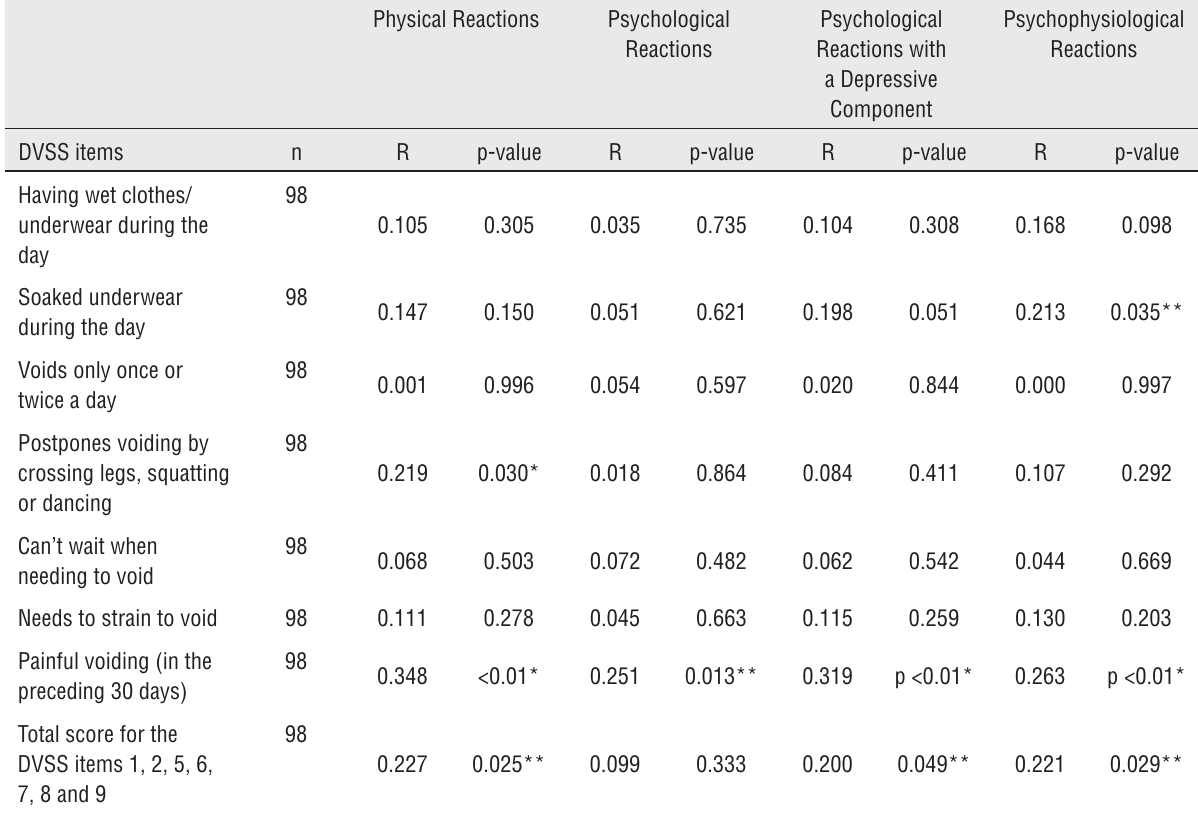
Table 3 - Correlation between the items evaluated in the Dysfunctional Voiding Scoring System (DVSS) and the domains of the Child Stress